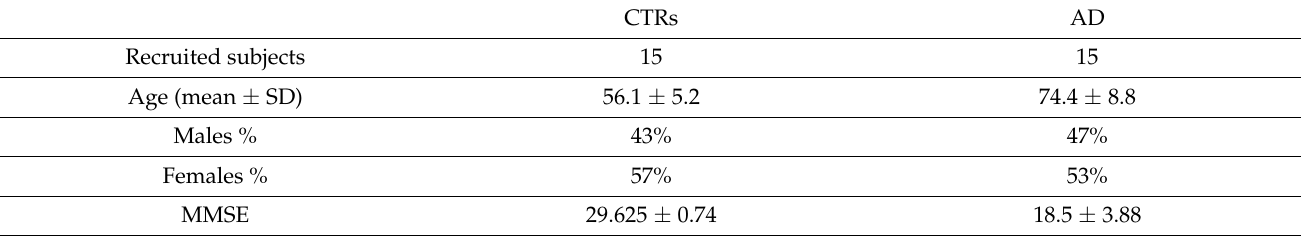
Table 3. Baseline characteristics of the subjects recruited for this